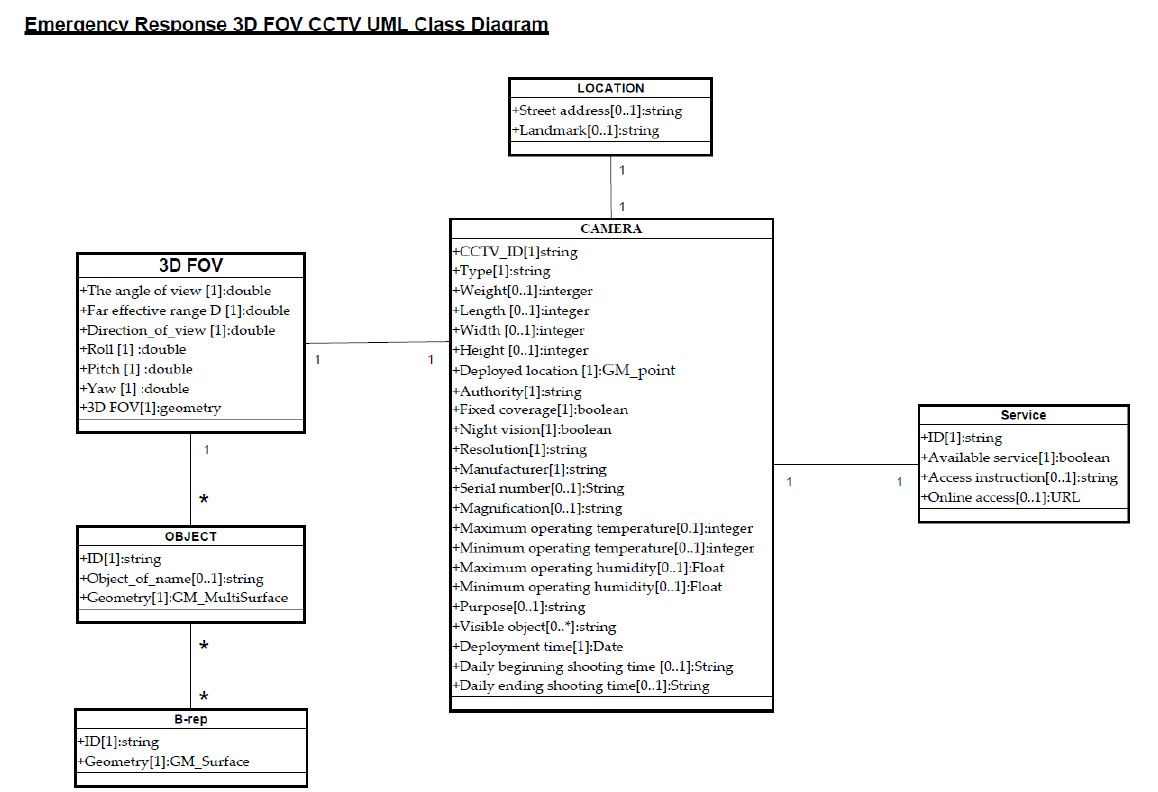
Figure 9. UML schema of the proposed CCTV metadata.